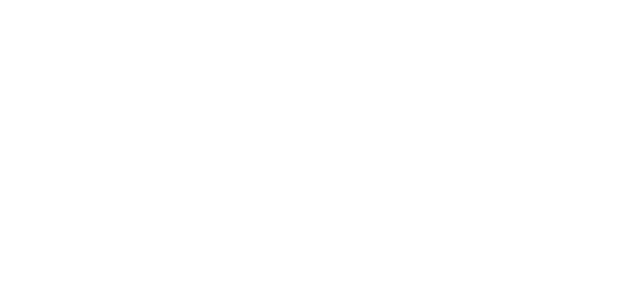
Table 2. Final diagnosis.